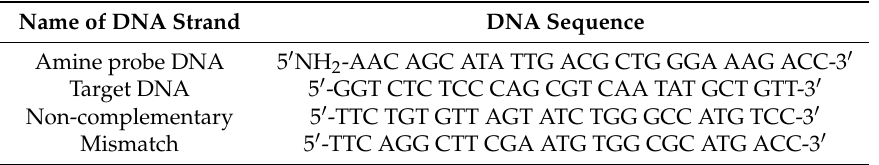
Figure 2. Schematic illustration of UV arrays.